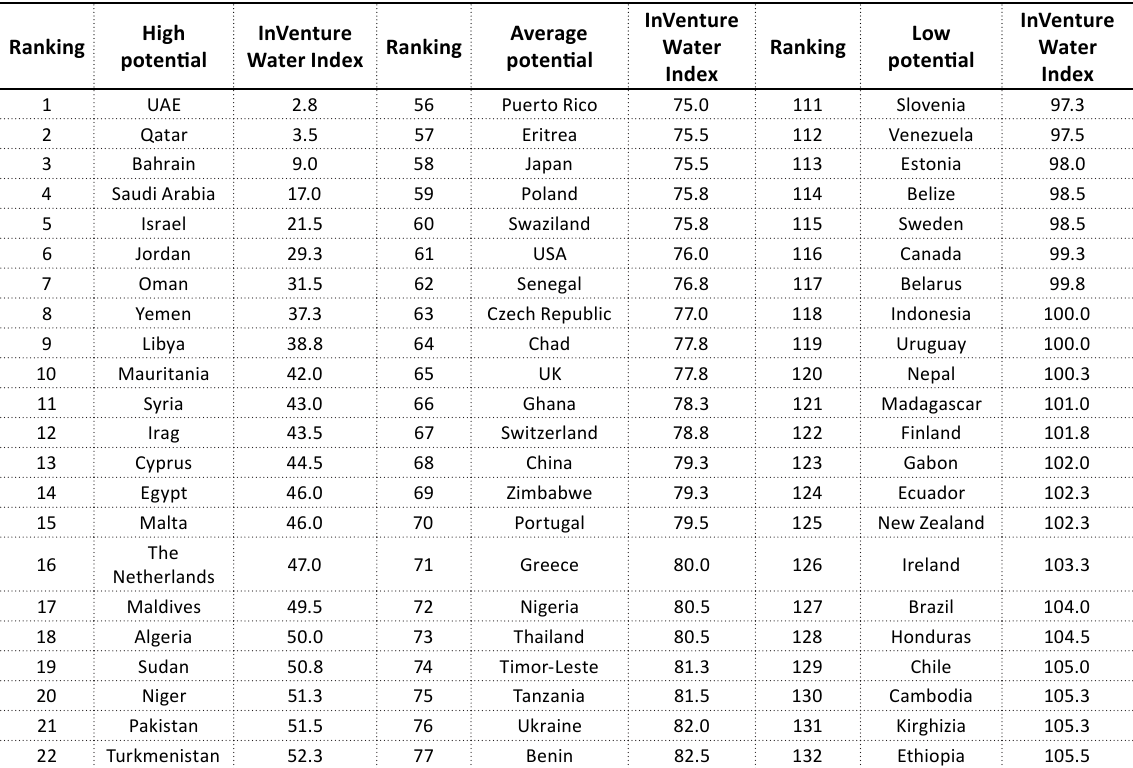
Table A2. Rating of investment-attractive countries in the context of the relevance of water production/water